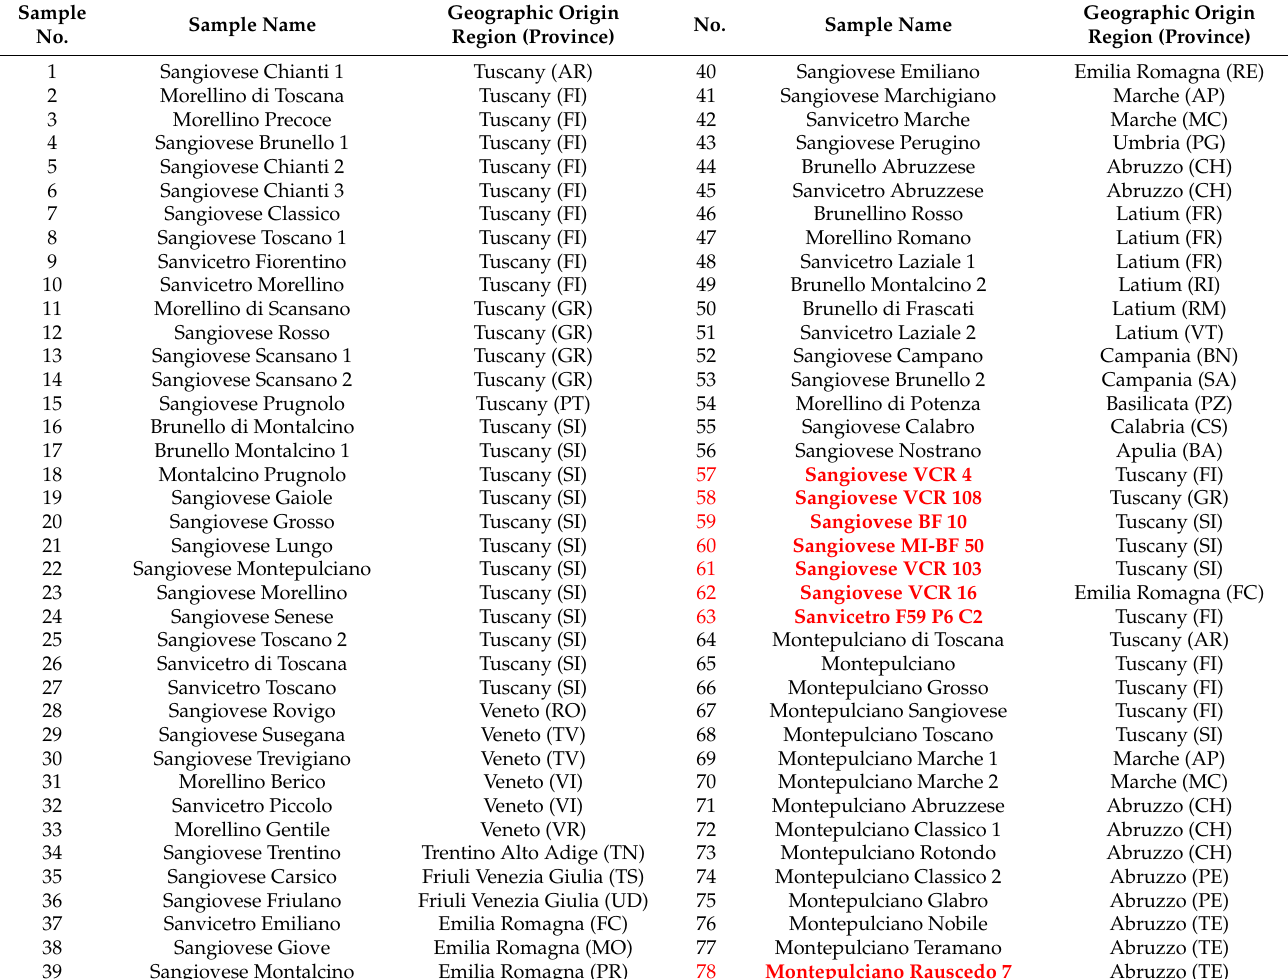
Table 1. List of the 78 grapevine samples screened: 56 putative Sangiovese, 14 putative Montepul- ciano, 7 reference clones, and 1 reference biotype are highlighted in bold